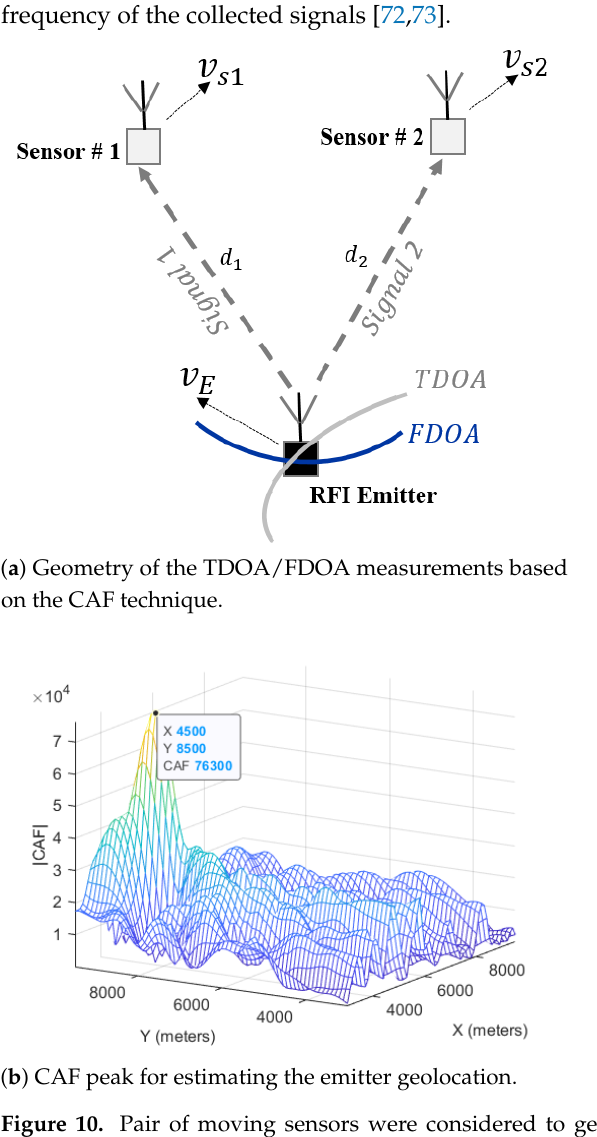
Figure 10. Pair of moving sensors were considered to geolocate a static RFI emitter using the CAF method. The simulation result achieved the peak of CAF that denotes an estimated RFI emitter position. Authors’ own